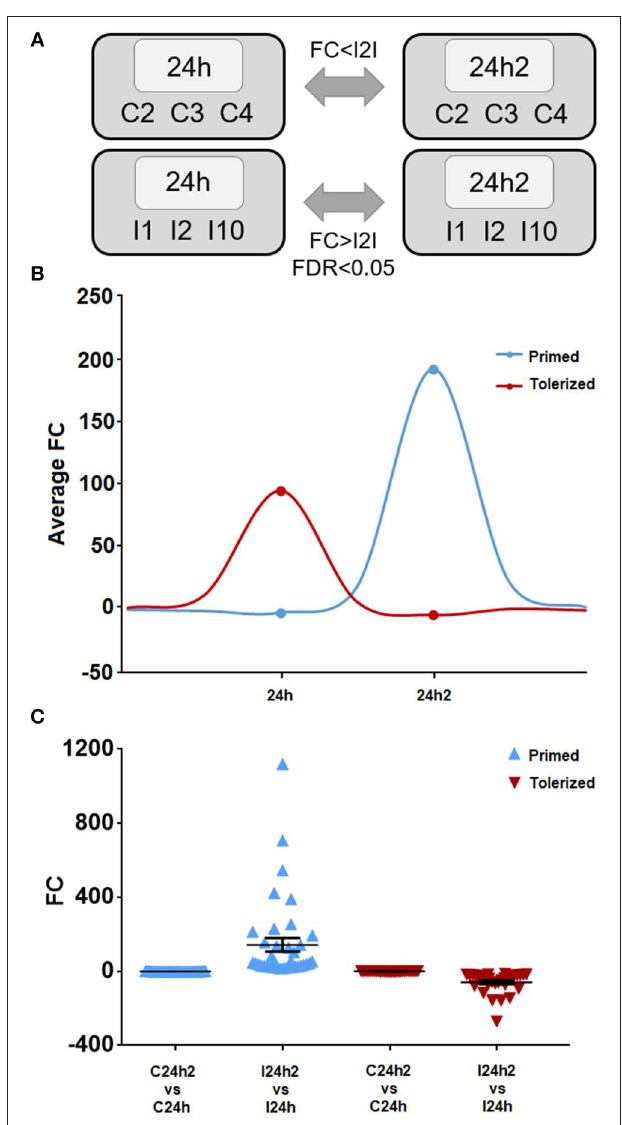
FIGURE 4 | (A) Representative scheme of the comparisons made to select the primed and tolerized genes. The statistical parameters used as thresholds were an FDR < 0.05 and a fold change (FC) > |2| in the case of Vibrio injected individuals and a FC < |2| in control mussels. (B) Mean of the tendency of the primed and tolerized genes. (C) Fold change of each primed and tolerized gene and their respective controls. The mean and standard error of all represented genes is also shown.